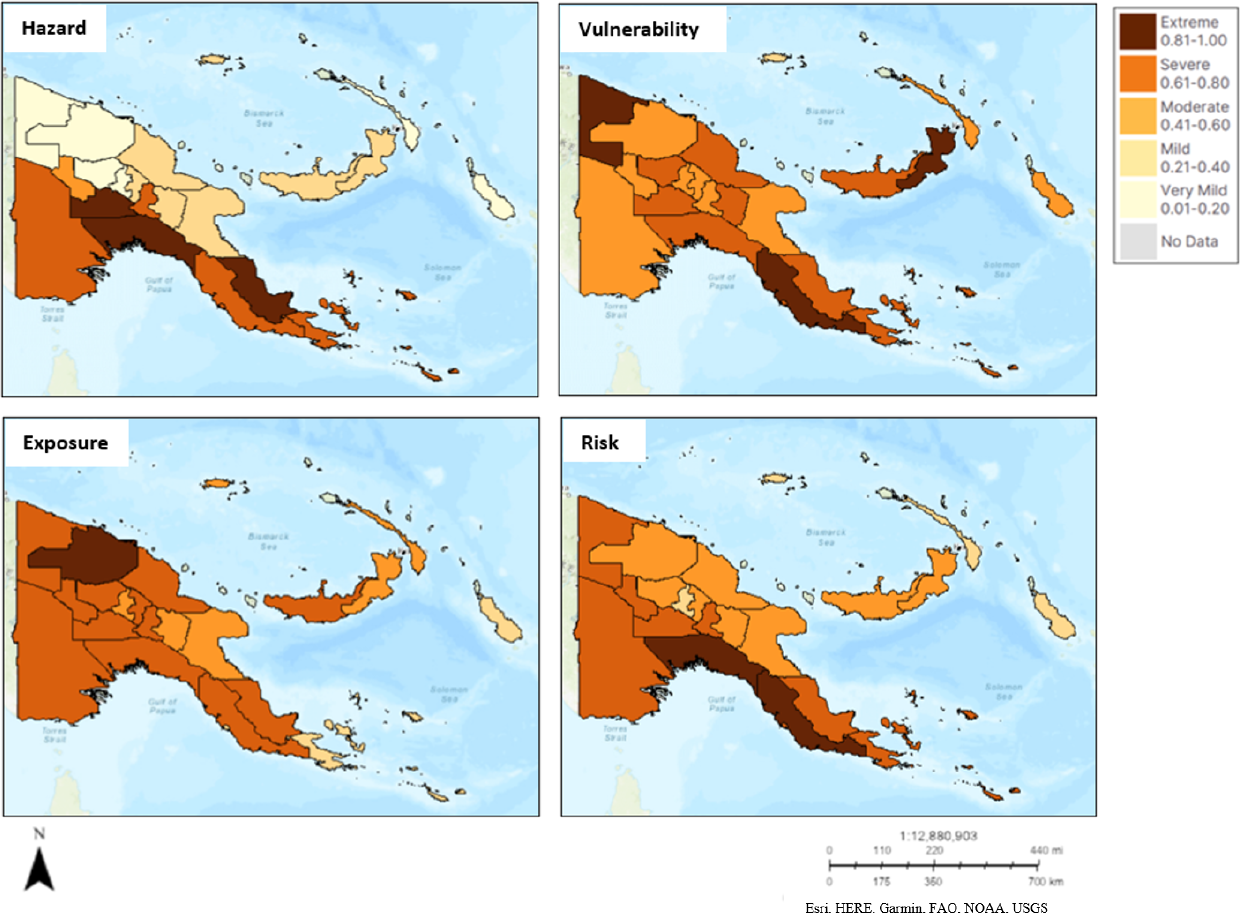
Figure 8. Overall drought risk maps of PNG provinces for 2019 including a drought hazard, drought vulnerability, drought exposure, and drought risk map detailing the index level of each province. The index level is classified on a deepening orange colour scale from very mild (index values from 0.01–0.20) to extreme (index values from